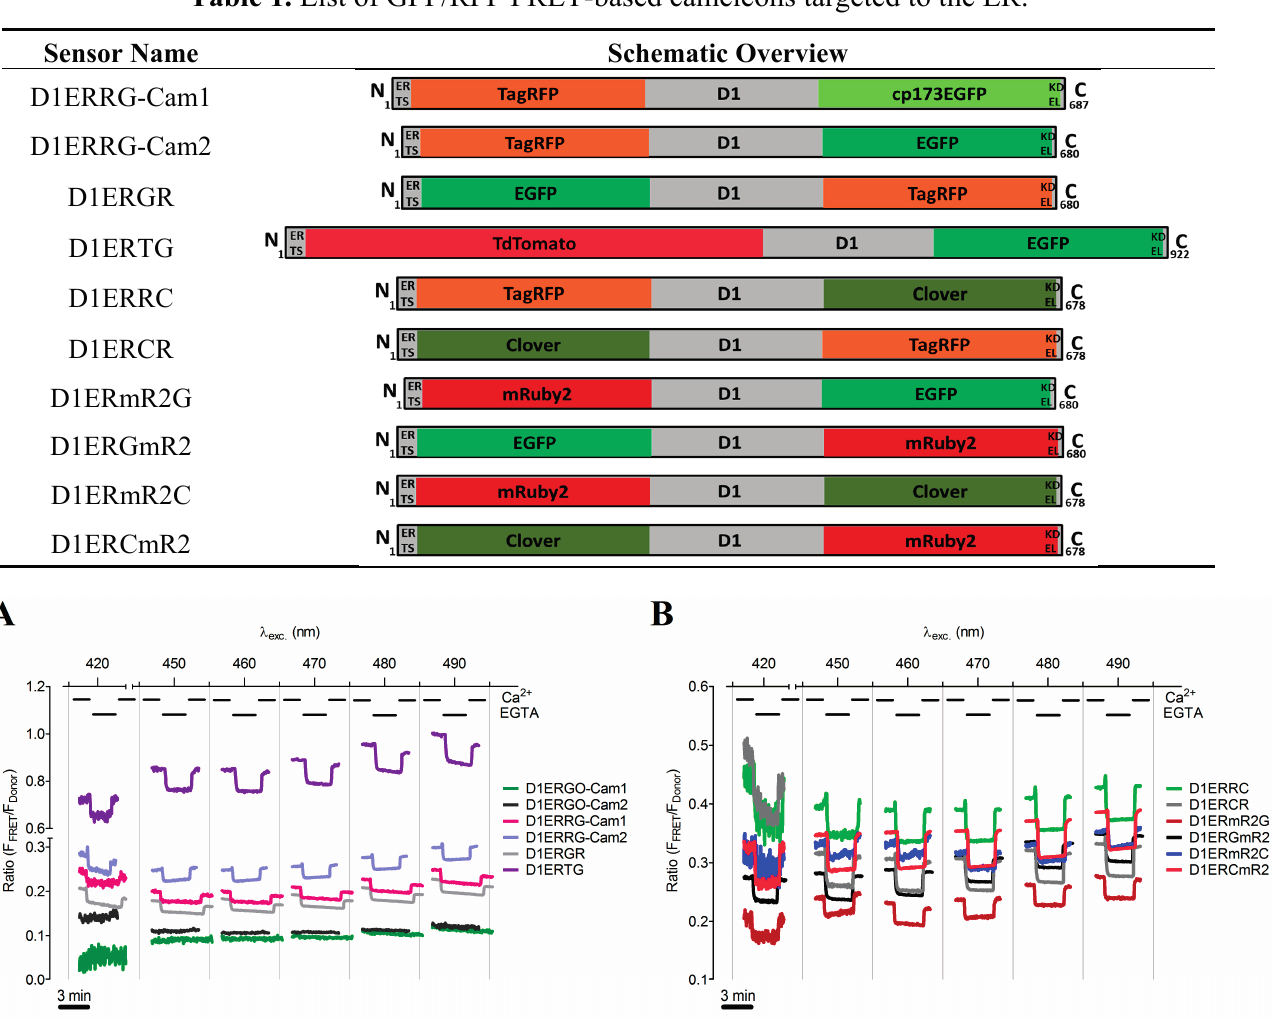
Table 1. List of GFP/RFP FRET-based cameleons targeted to the ER.